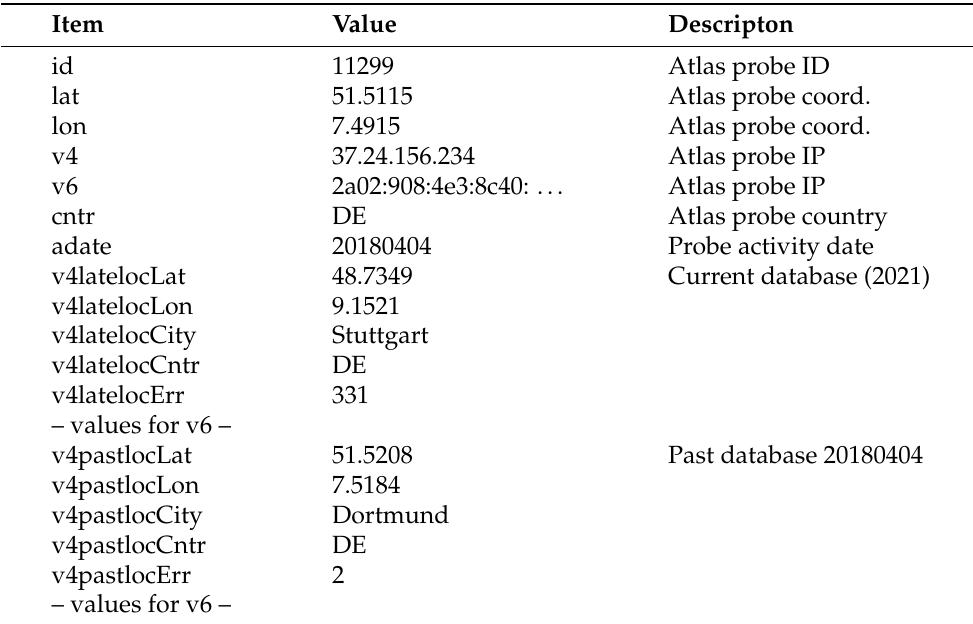
Table A3. Format of file 2016–2021_history.csv with processed historical data and sample.